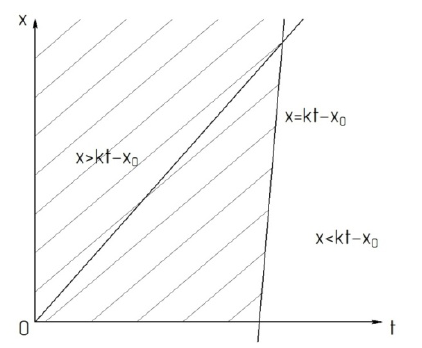
Fig. 6. Area solutions.